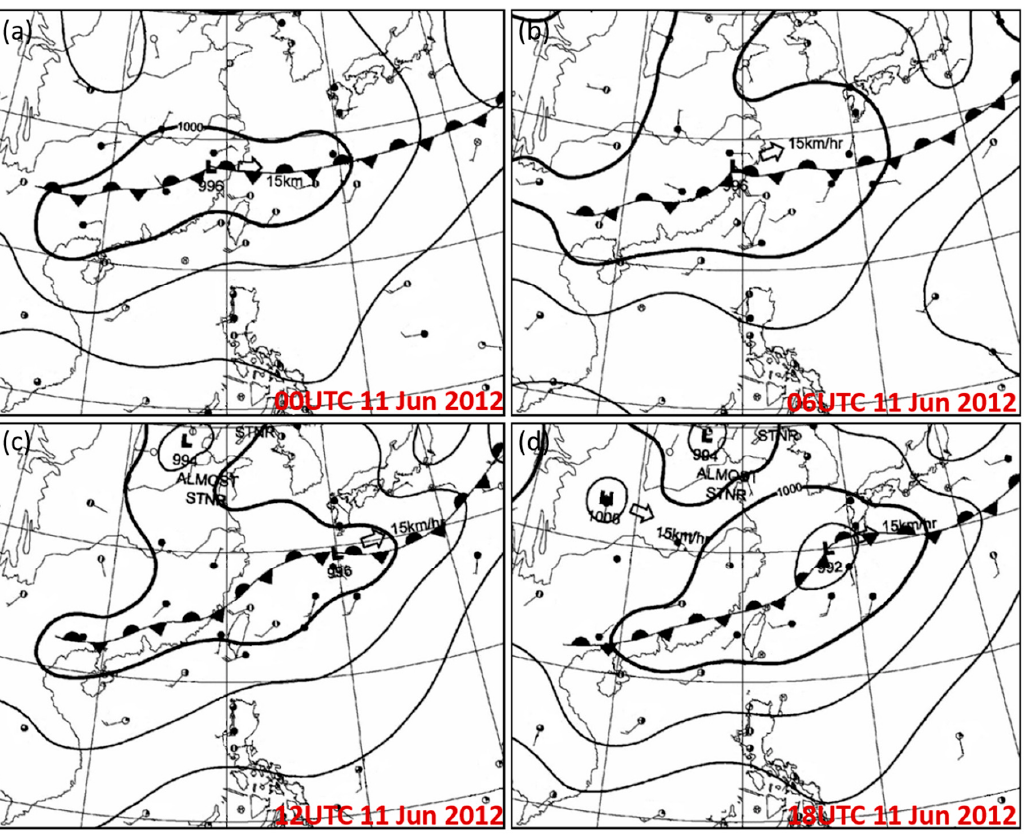
Figure 1. Synoptic charts of Mei-Yu frontal system at: ( a ) 0000 UTC; ( b ) 0600 UTC; ( c ) 1200 UTC; and ( d ) 1800 UTC on 11 June 2012. The quasi-stationary frontal system was between Korean peninsula and Taiwan on this day, and gradually moved toward the northern Taiwan.